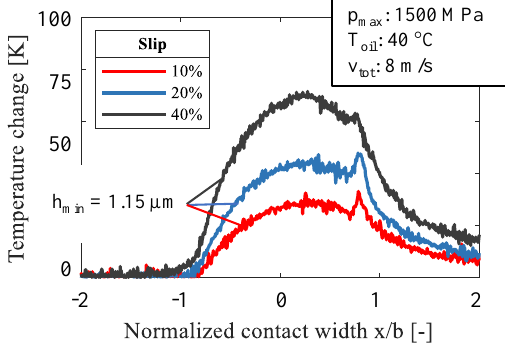
Figure 8. Comparison of slip at fluid friction.